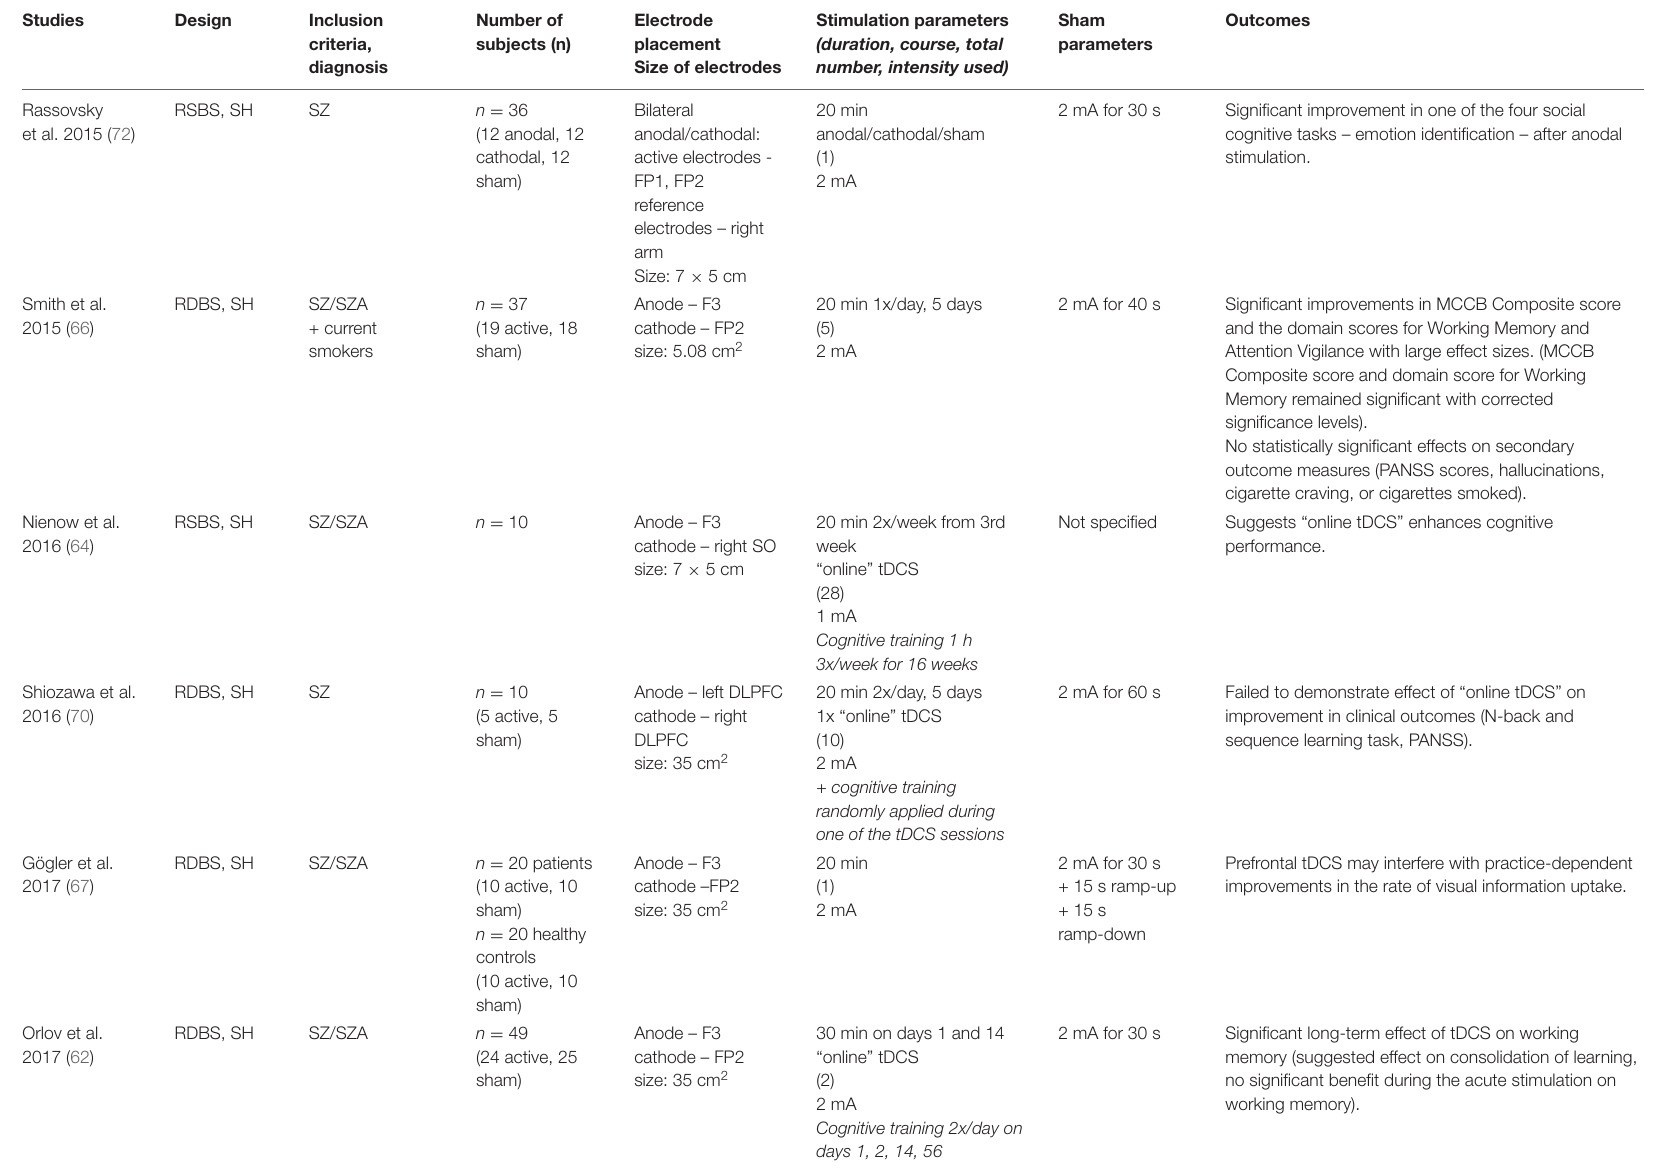
TABLE 3 | Effects of tDCS on cognitive